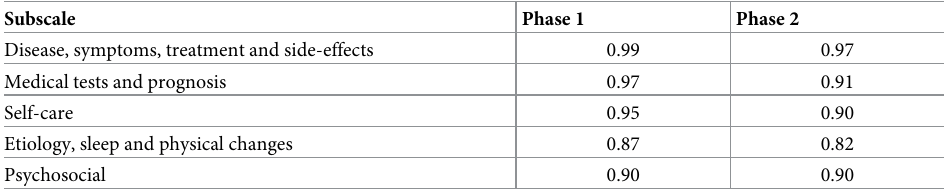
Table 4. Internal consistency (Cronbach’s α ) of subscales of the HINQ. Subscale Phase 1 Phase 2 Disease, symptoms, treatment and